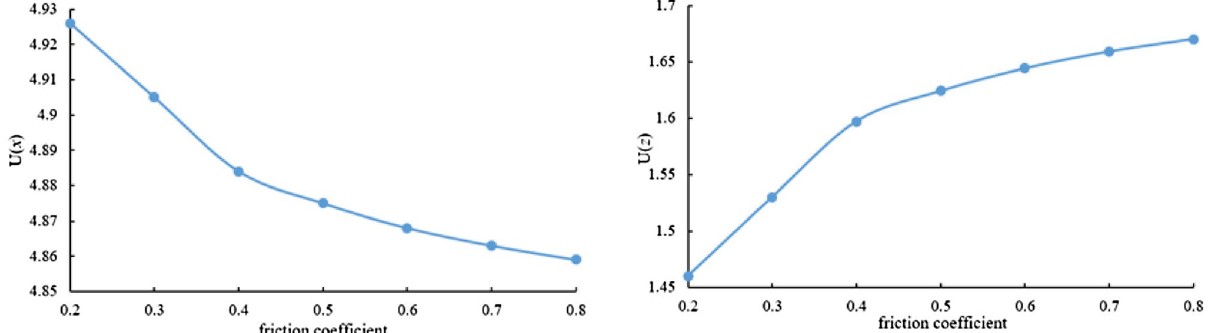
Fig. 9 Displacements when friction coefficient